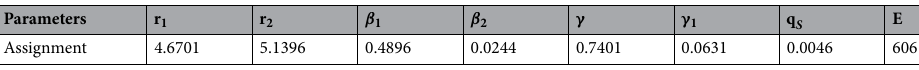
Table 1. Estimated results of epidemic parameters in